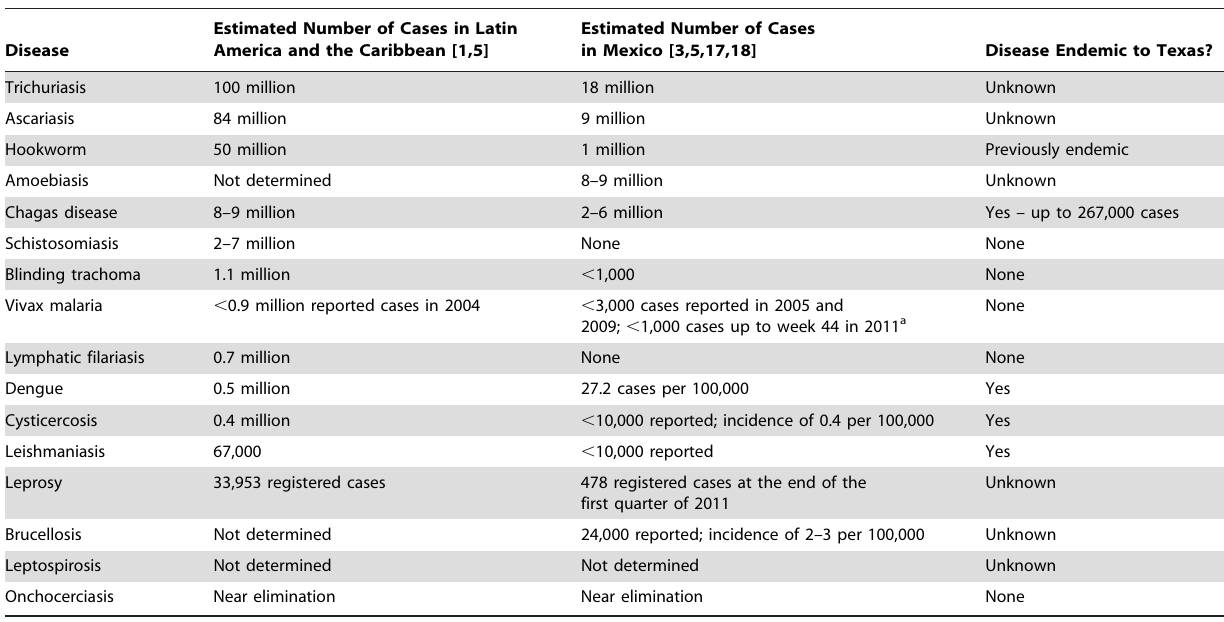
Table 1. The major NTDs of the Latin American and Caribbean region, Mexico, and Texas.